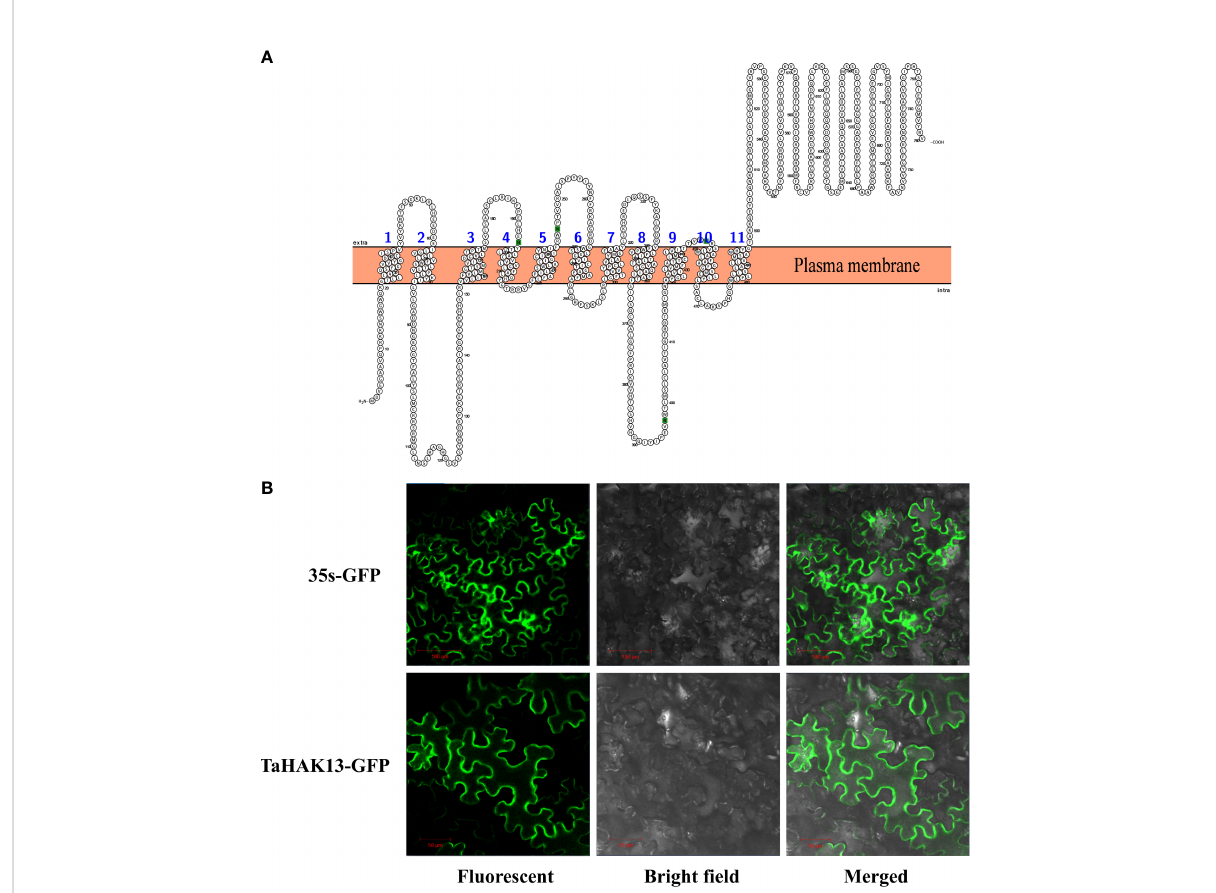
FIGURE 2 Characteristics of TaHAK13. (A) Predicted transmembrane domains of TaHAK13. (B) Subcellular localization of TaHAK13 in tobacco leaves. 35S- GFP acted as the control. Bar = 50 or 100 m